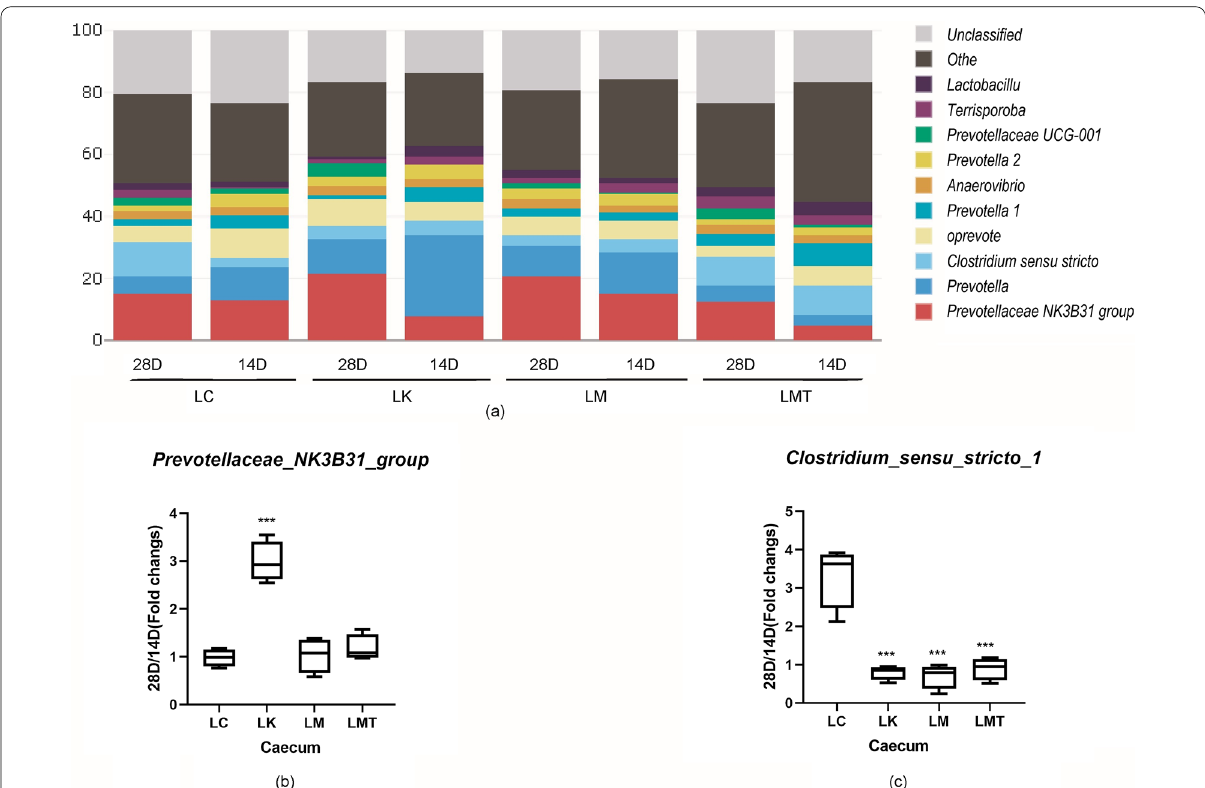
Fig. 7 Composition of the cecum microbiota at the genus level. a1 The effect of the TCM formula on the composition of the cecum microbiota at the genus level in the weaned piglets. b The fold change in the relative abundance of the genus Prevotellaceae NK3B31 (28 d/14 d ratio). c The fold change in the abundance of the genus Clostridium sensu stricto 1 (28 d/14 d ratio) ( *p < 0.05; **p < 0.02; ***p < 0.01,